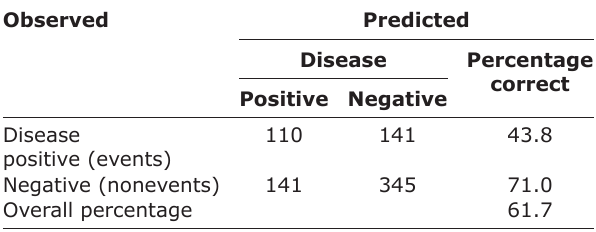
Table-7: A classification table and predictive accuracy of the full model (the cutoff point is 0.5).